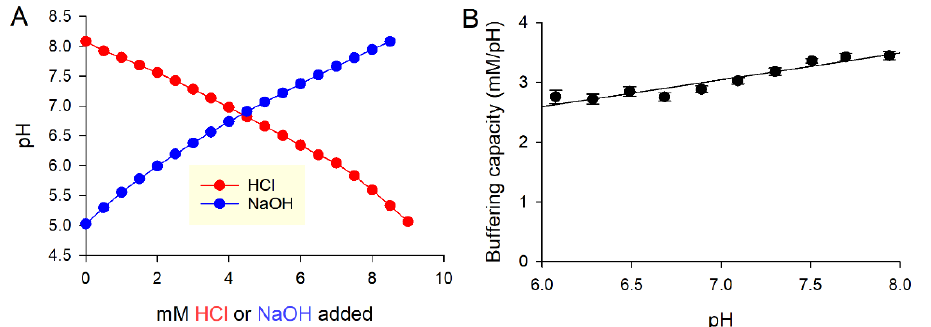
Figure 3 . Measuring the pH buffering capacity. ( A ) Stepwise addition of 0.5 mM HCl or NaOH to media of undetermined buffering capacity. The inverse of the slope gives average buffering capacity for the entire pH range. ( B ) Buffering capacity expressed as the ratio of HCl (or NaOH) added to pH change, plotted against the midpoint of the pH change. The best fit line accounts for pH-sensitivity of buffering capacity. This function should be used whenever converting between pH changes and H + fluxes.